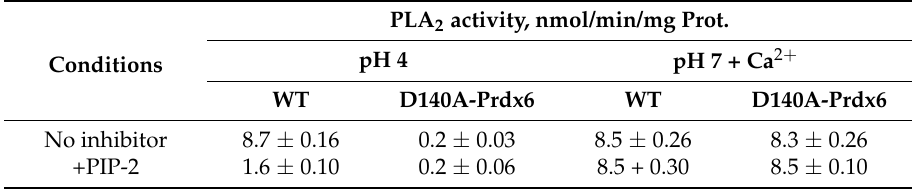
Table 6. PIP-2 specificity as an inhibitor of aiPLA 2 as shown by the lack of effect on other PLA 2